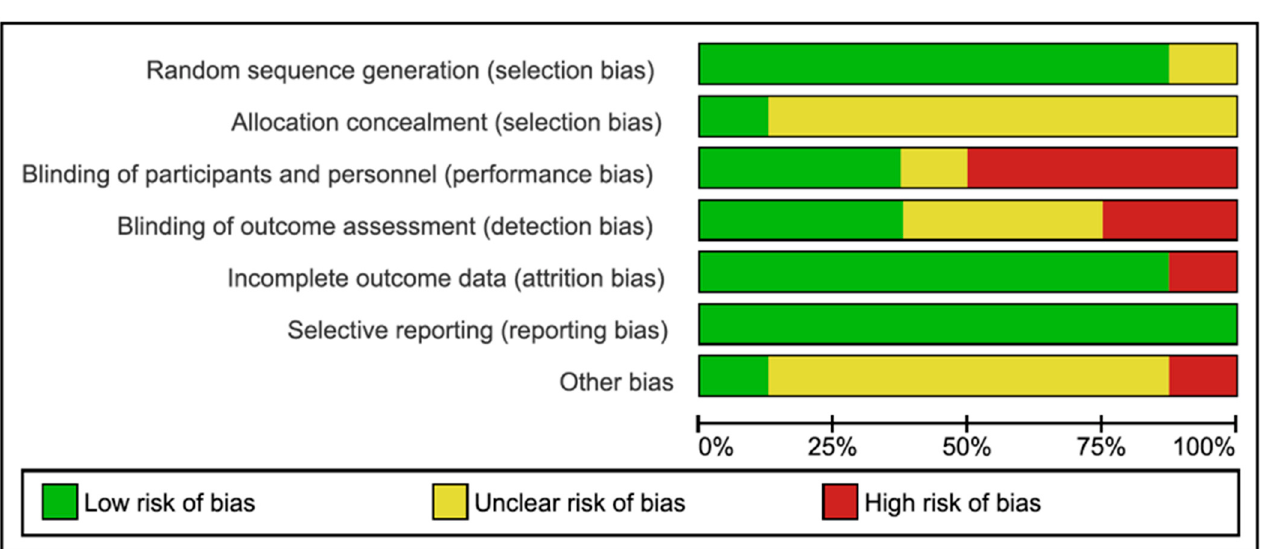
Figure 2. Risk of bias graph: Review authors’ judgments about each risk of bias item presented as percentages across all included studies.